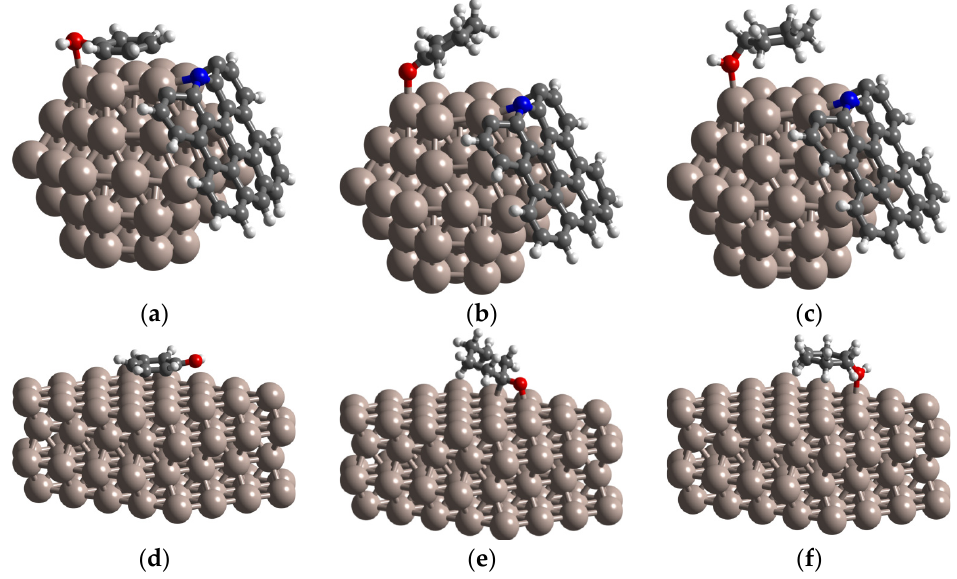
Table 1. The calculated H 2 decomposition energy barrier (eV) on Ru@N-CS and Ru (002).